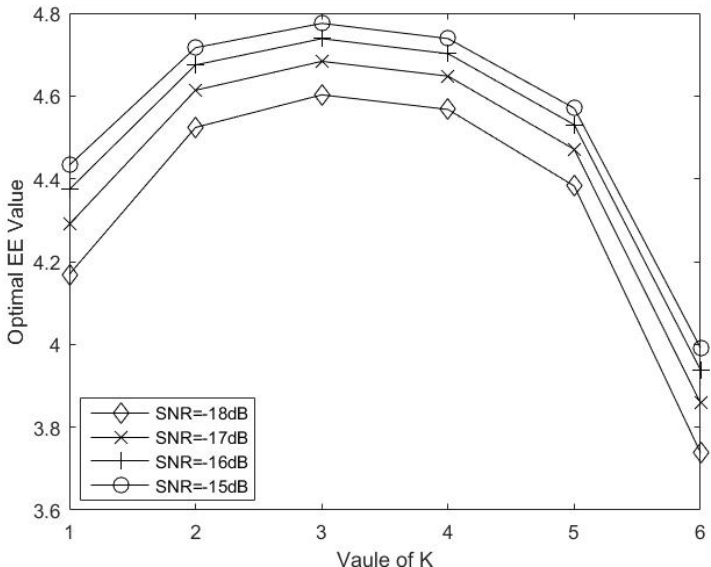
Figure 6. Optimal EE under different fusion rules.